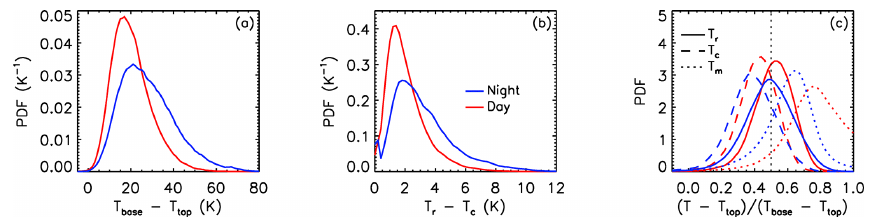
Figure 7. Nighttime (blue) and daytime (red) probability density functions in V4 opaque ice clouds of (a) apparent thermal thickness T base − T top , (b) T r − T c V4 correction, and (c) ( T − T top ) / ( T base − T top ) for T = T r (solid lines), T = T c (dashed lines), and T = T m (dotted lines) over oceans between 60 ◦ S and 60 ◦ N in January 2008. Results are for channel 12.05µm.